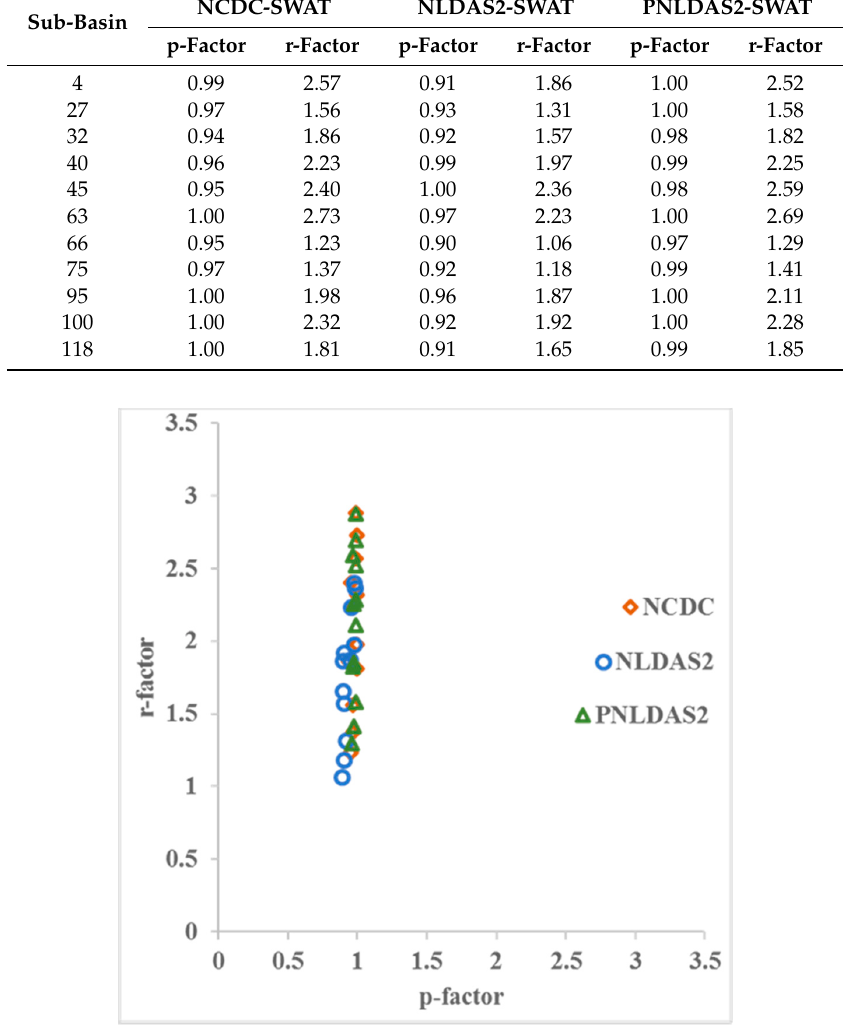
ff erent sub-basin in three simulation